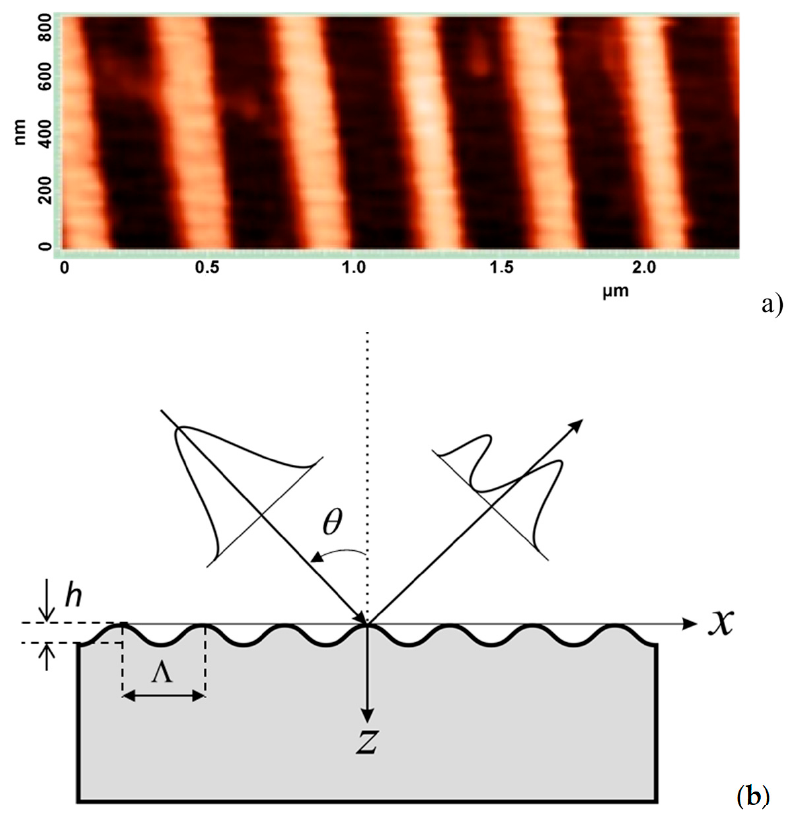
Figure 1. Image of grating ( a ) and reflection of a Gaussian beam by a metallic grating ( b ).